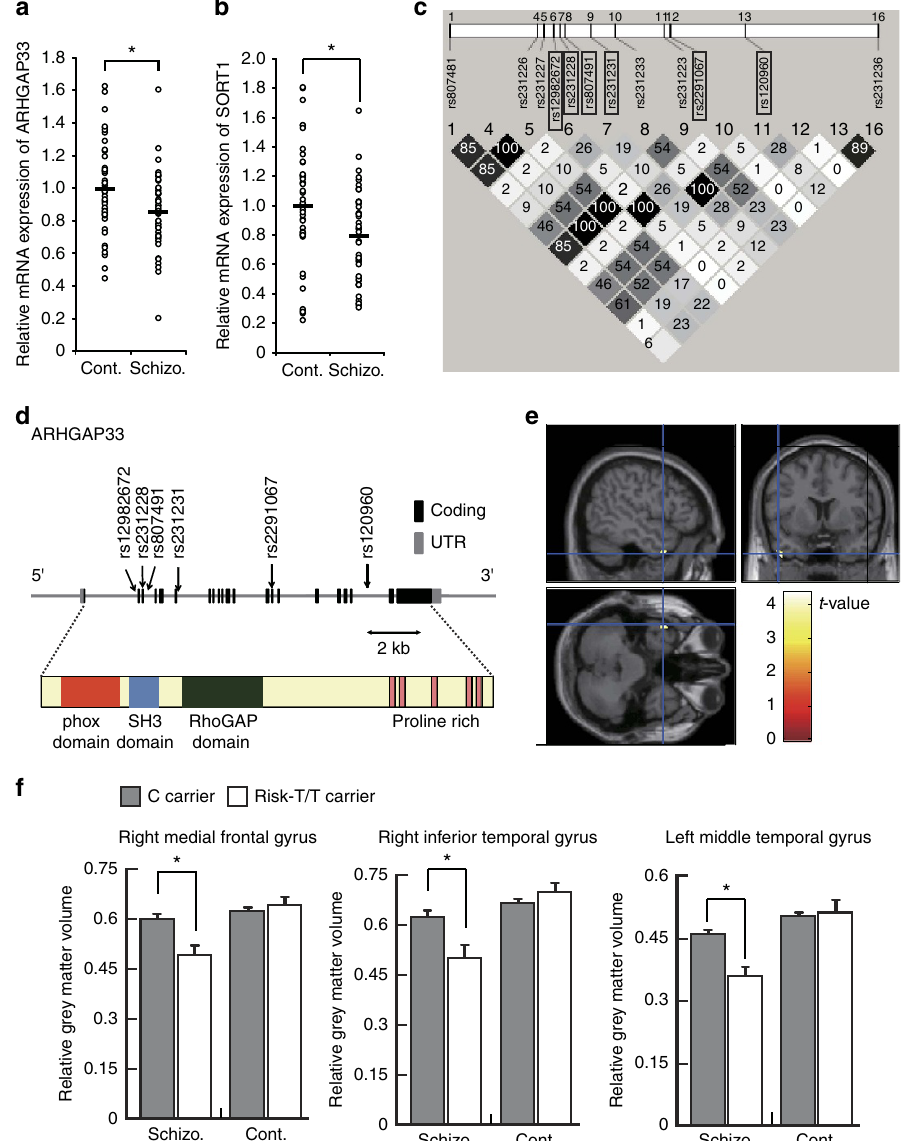
Figure 8 | Association of ARHGAP33 with schizophrenia. ( a , b ) Quantitative RT–PCR analysis of ARHGAP33 and SORT1 expression in immortalized lymphocytes from schizophrenia patients (schizo.) and age- and sex-matched controls. Significant reductions are observed in ARHGAP33 (each n ¼ 45, U ¼ 699, P ¼ 0.011, Mann–Whitney U -test; a ) and SORT1 (each n ¼ 45; U ¼ 683, P ¼ 7.8 (cid:2) 10 (cid:3) 3 , Mann–Whitney U -test; b ) in schizophrenia patients. The expression levels of these genes were normalized to GAPDH mRNA. Bars show median values. ( c ) Linkage disequilibrium of ARHGAP33 in the HapMap JPT. Each diamond represents the correlation ( r 2 ) between each pair of SNPs, with darker shades representing stronger linkage disequilibrium, as obtained from the HapMap JSTsamples. ( d ) The locations of the SNPs analysed in this study. ( e , f ) Impact of the risk-T-allele on grey matter volume of the left middle temporal gyrus in schizophrenia patients. A significant cluster of the genotype effect in the left middle temporal gyrus is observed in schizophrenia patients, which is shown as cross-hairline (uncorrected P o 0.001, cluster size 4 100; e ). Relative grey matter volumes extracted from the left middle temporal gyrus (F 1,122 ¼ 13.5, P ¼ 3.6 (cid:2) 10 (cid:3) 4 , ANOVA), the right medial frontal gyrus (F 1,122 ¼ 13.5, P ¼ 8.2 (cid:2) 10 (cid:3) 4 , ANOVA) and the right inferior temporal gyrus (F 1,122 ¼ 13.1, P ¼ 4.4 (cid:2) 10 (cid:3) 4 , ANOVA; f ). * P o 0.05. Data are expressed as the mean ±